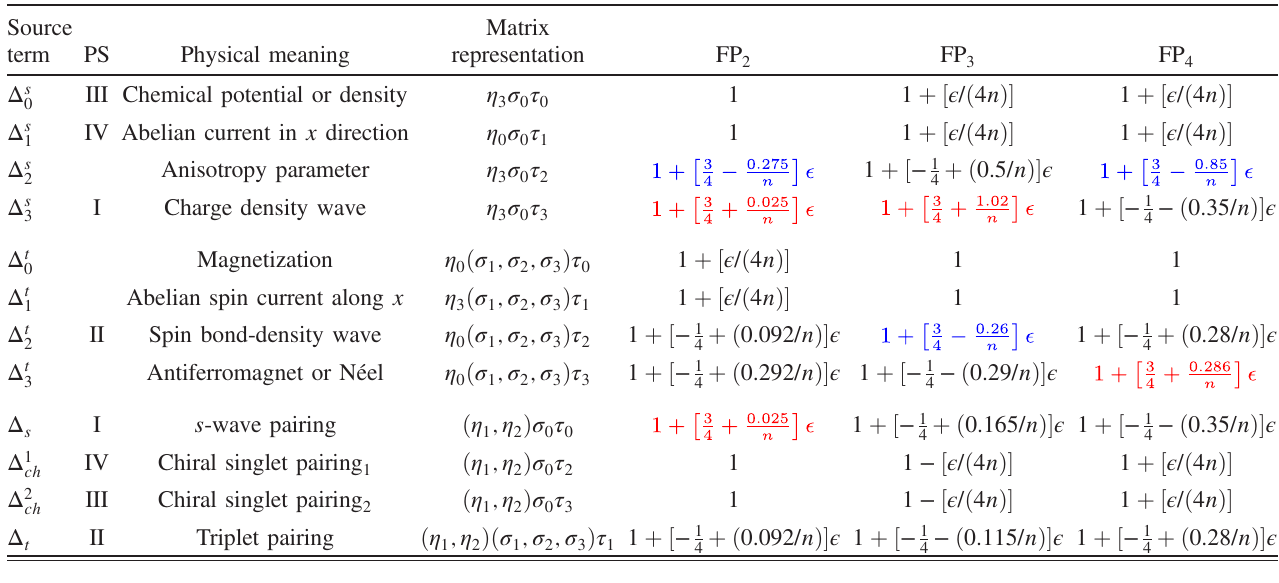
TABLE V. The scaling dimensions (SDs) of the source term coupling constants conjugate to various fermionic bilinears at three ˆ Δ interacting quantum critical points (QCPs), FP 2 , FP 3 , and FP 4 , possessing only one unstable direction in the ð l Þ ¼ 0 hyperplane (see text for details). Note that, at each QCP, we display the largest SD in red and subdominant SD in blue. As we take n → ∞ (strict one- dimensional system), the red and blue channels possess exactly equal SDs and constitute an O(4) vector. However, such O(4) symmetry gets lifted once the 1 / n corrections are systematically accounted for. Upon incorporating the 1 / n corrections, the SD for one of the fully gapped (true mass) orders (CDW, AFM, s -wave pairing) for the two-dimensional anisotropic semimetal is largest at each QCP. We, therefore, anticipate that FP 2 , FP 3 , and FP 4 , respectively, nucleate CDW/ s -wave pairing, CDW order, and N´eel antiferromagnetism. Here, all fermionic bilinears are presented in the Nambu-doubled spinor basis introduced in Eq. (37) (see also Appendix C), and the Pauli matrices η μ ¼ f η 0 ; η 1 ; η 2 ; η 3 g operate on the Nambu index. The column PS indicates bilinears that transform together under pseudospin SU(2) rotations; see Fig. 11. The other fermion bilinears transform as scalars under pseudospin